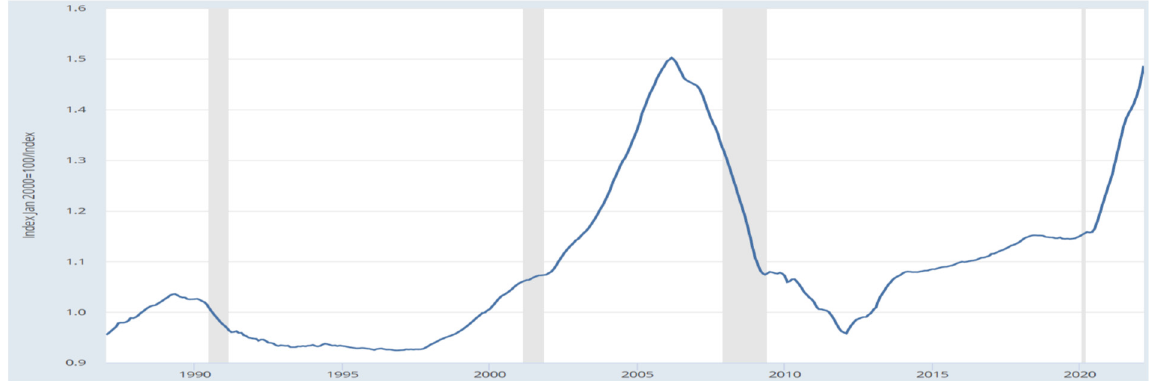
Figure 17. Ratio of S&P Case Shiller Price Index to CPI-U: Rent of Primary Residence in the US. Source: S&P Dow Jones; Labor Department.